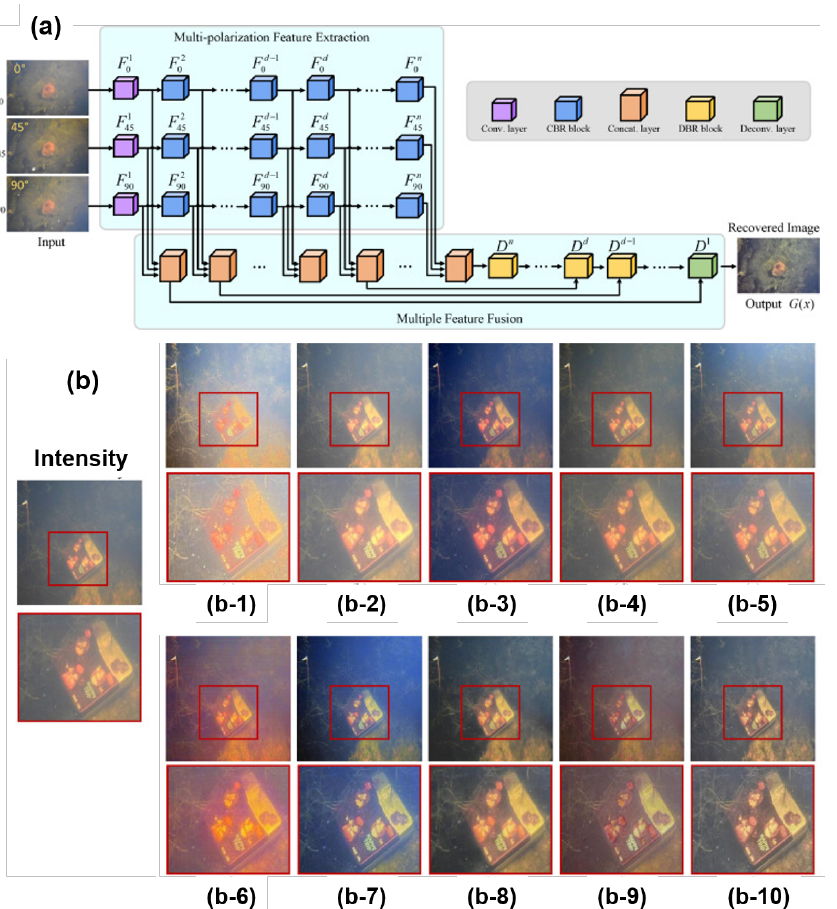
Figure 20. ( a ) Architecture of the multi-polarization fusion generator network for underwater image recovery [259]. ( b ) Comparisons of different methods on the images captured in natural underwater environments. ( b-1 ) [260], ( b-2 ) [230], ( b-3 ) [261], ( b-4 ) [262], ( b-5 ) [263], ( b-6 ) [264], ( b-7 ) [265], ( b-8 ) [266], ( b-9 ) [267], ( b-10 )